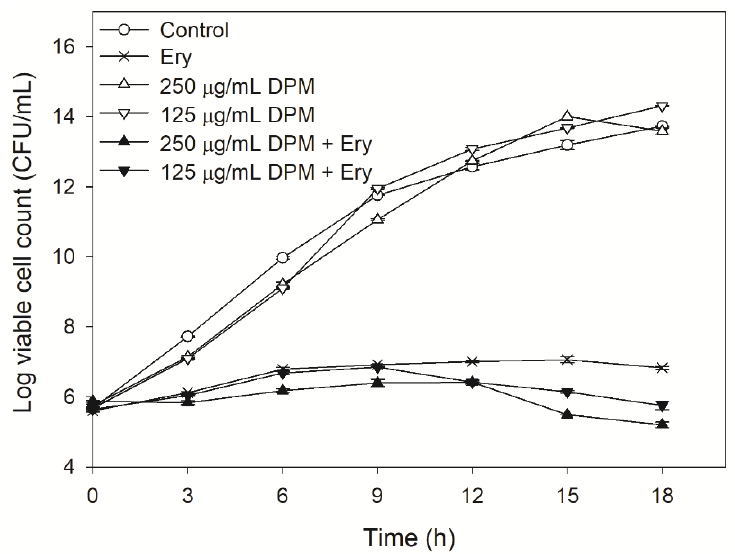
Figure 1. Time-kill curve of E. coli Kam3-AcrB with erythromycin, diphenylmethane, and in combination. Ery, Erythromycin; DPM, diphenylmethane. Data are expressed as mean ± SD ( n = 3).